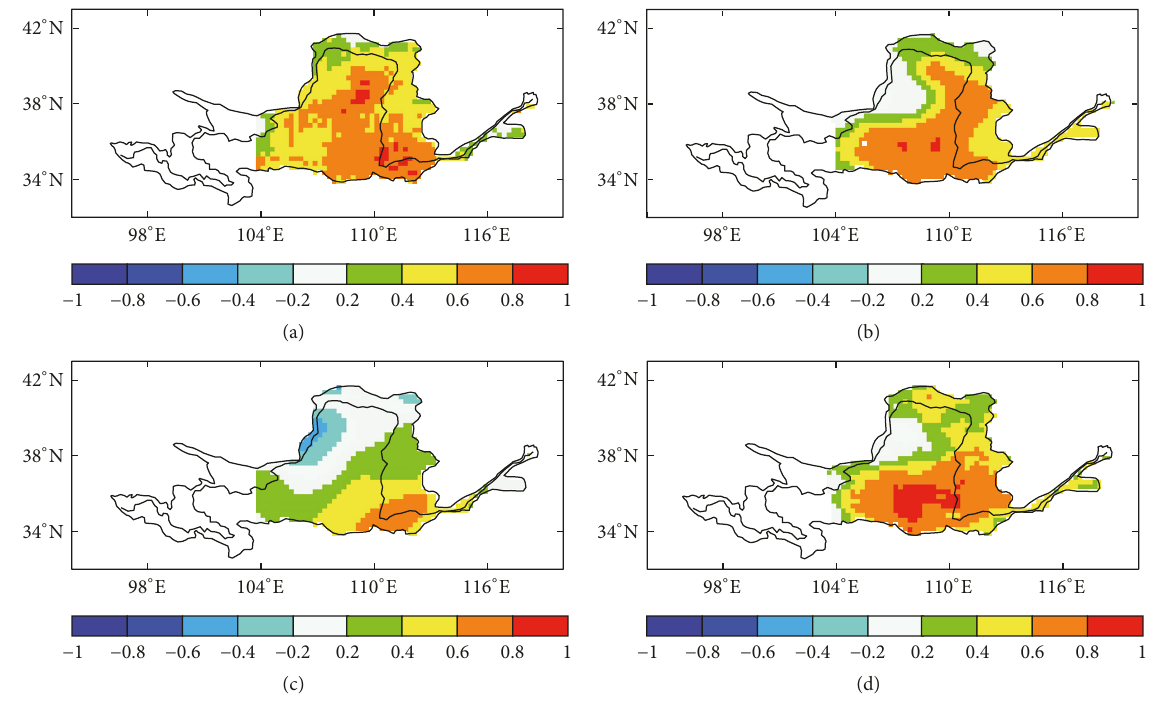
Figure 5: The correlation coefficients of interannual variations between SM in situ and (a) SM ECV , (b) SM ERA , (c) SM NCEP , and (d) SM VIC in the period of